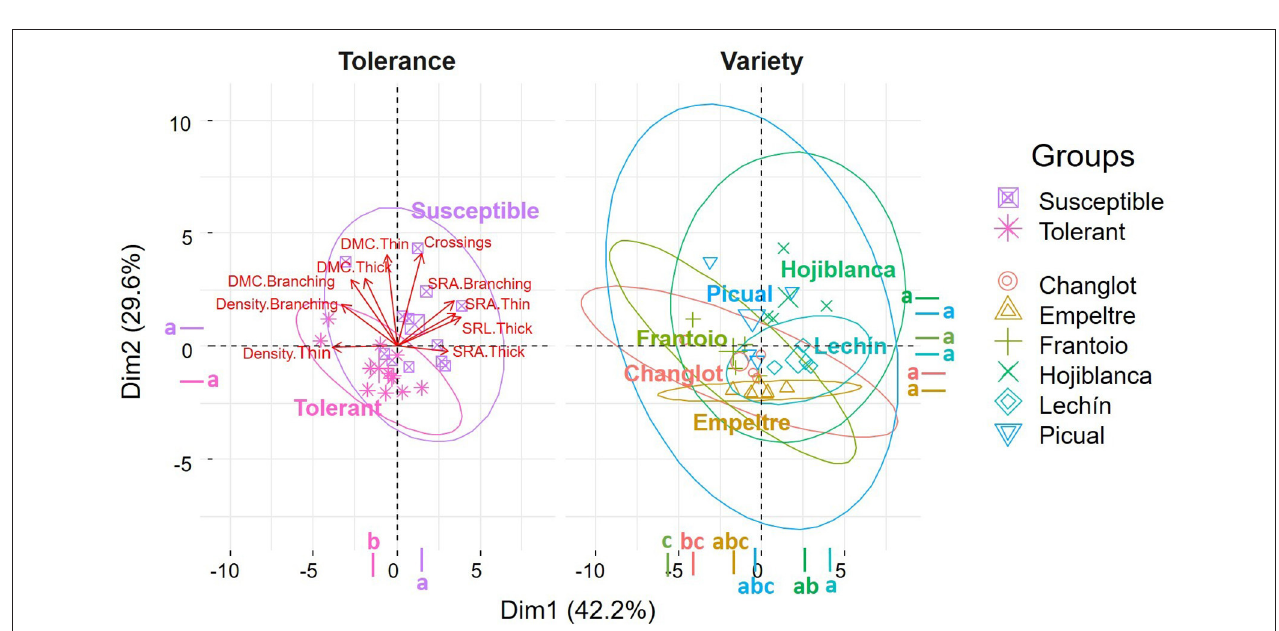
FIGURE 3 | Principal Component Analysis (PCA) of root functional traits performed with “tolerance” and “variety” as factors. Different letters indicate significant differences between groups (Tukey’s test, p < 0.05). Functional traits with a contribution to the two dimensions higher than 5% were considered for the analysis.